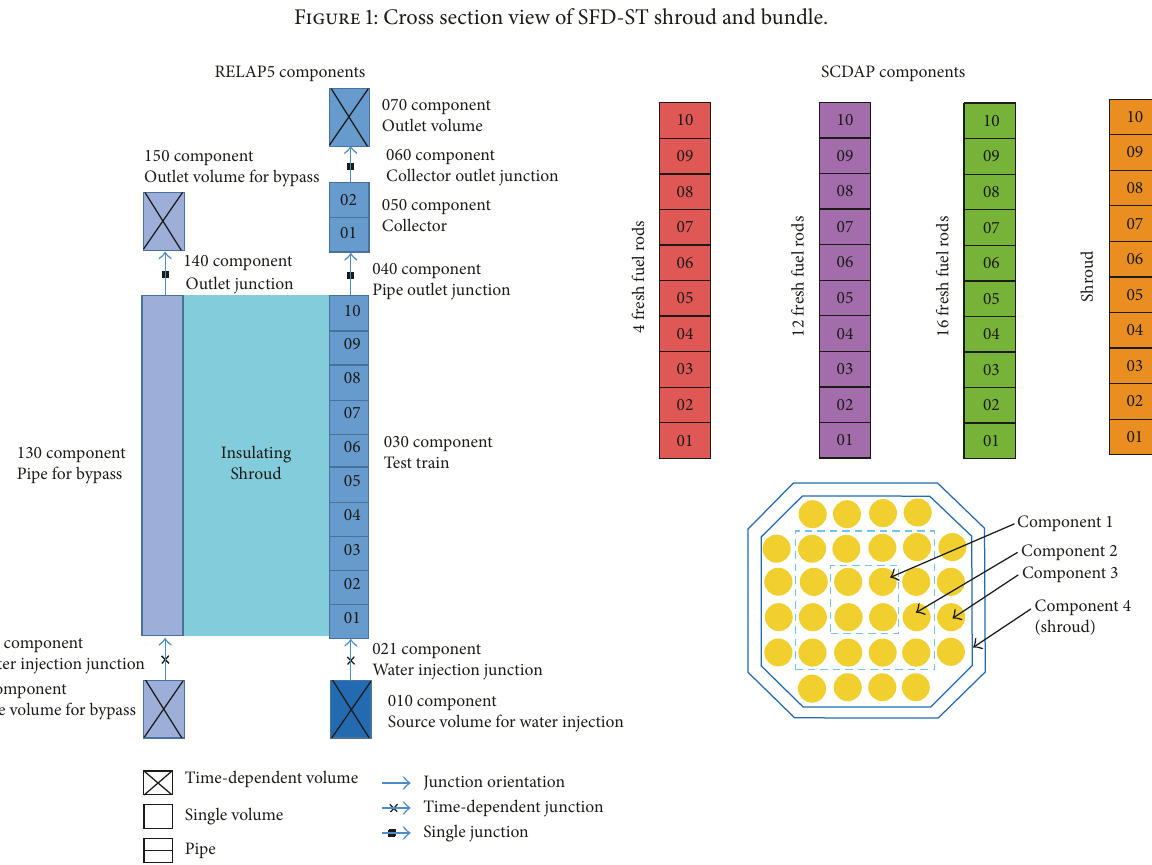
Figure 2: Nodalization of the PBF SFD-ST